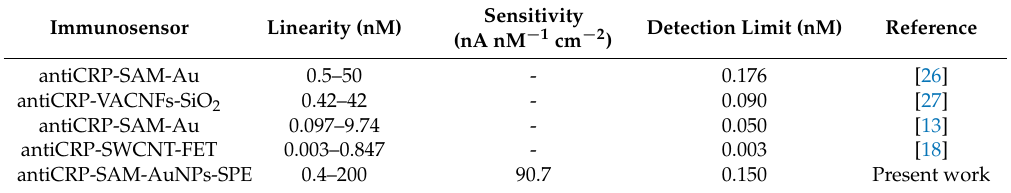
Figure 4. ( A ) Time vs. current response of the CRP immunosensor for (a) 1, (b) 2, (c) 5, (d) 7, (e) 10, (f) 15, (g) 20, and (h) 25 nM of CRP. ( B ) Calibration chart of the anodic oxidation current vs. CRP concentration ranging from 0.4–200 nM ( y = 0.09 x − 23.9, r 2 = 0.9985). The values for each point were averaged over three measurements. ( C ) Histograms representing the selectivity of the label-free CRP immunosensor toward CRP, CRP + Glucose, CRP + ascorbic acid, and CRP + BSA in PBS solution containing 0.5 mM Fe(CN) 64 − at a scan rate, 50 mV s − 1 . ( D ) Histograms representing the stability of the immunosensor strip under the same working conditions as described in the text. Table 1. Electroanalytical properties of earlier reported label free CRP immunosensors, including the present